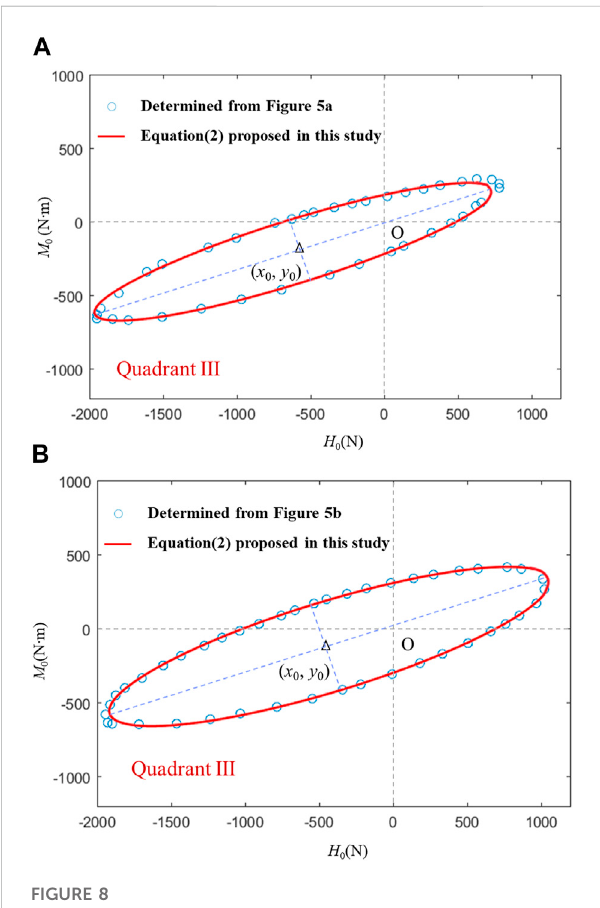
FIGURE 8 Failure envelope of bearing capacities of single piles near slopes: (A) d pc = 0 D and (B) d pc = 4 D .